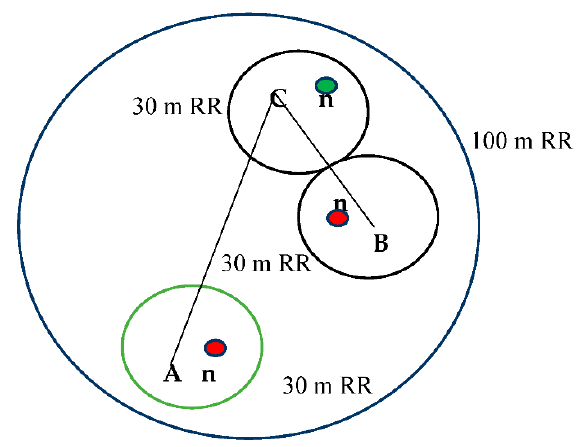
Figure 2. Spoofing Attack through Received Signal Strength (RSS).